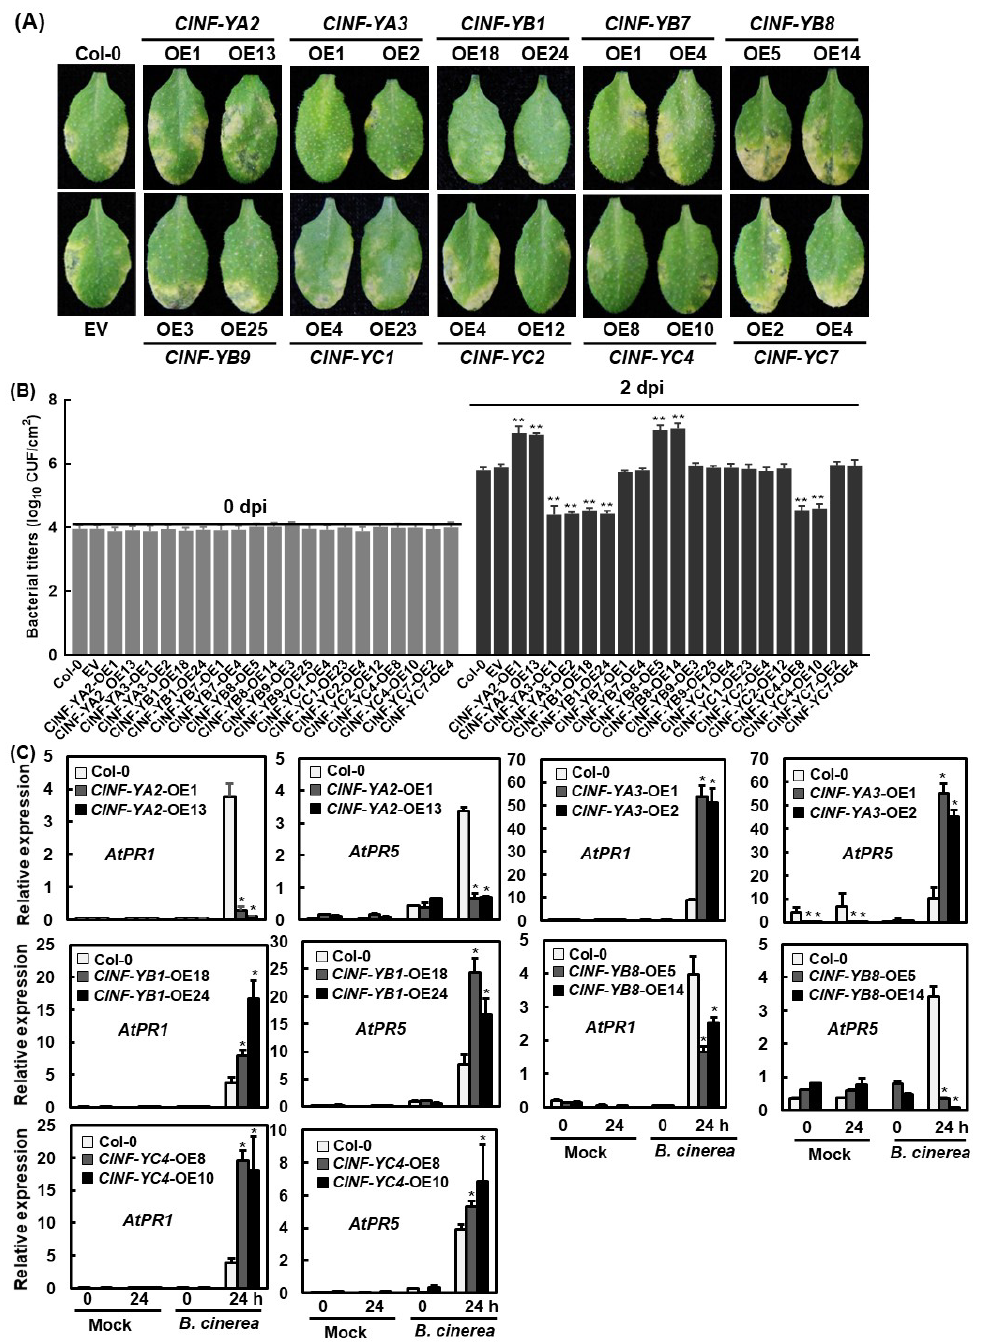
Figure 10. Pseudomonas syringae pv. tomato DC3000-caused disease phenotype on leaves of the ClNF- Y -overexpressing and WT Arabidopsis plants. ( A ) Disease symptoms and ( B ) bacterial growth titers in inoculated leaves. Fully expanded leaves of four-week-old plants were inoculated by injecting with P. syringae pv. tomato DC3000 suspension (OD 600 = 0.0002) and photographed at 3 dpi. Leaf samples were collected at 0 and 2 dpi and bacterial growth in CFU/(cm 2 leaf area) is shown. ( C ) Expression changes of defense genes in WT and transgenic OE plants with or without infection of P. syringae pv. tomato DC3000. Four-week-old plants were inoculated with P. syringae pv. tomato DC3000 and leaf samples were collected at 0 and 24 h post-inoculation. Experiments were performed three times with similar results. Data presented in ( B , C ) are the means ± SD and */** above the columns indicate significant differences at the p < 0.05 and p < 0.01 levels, respectively.